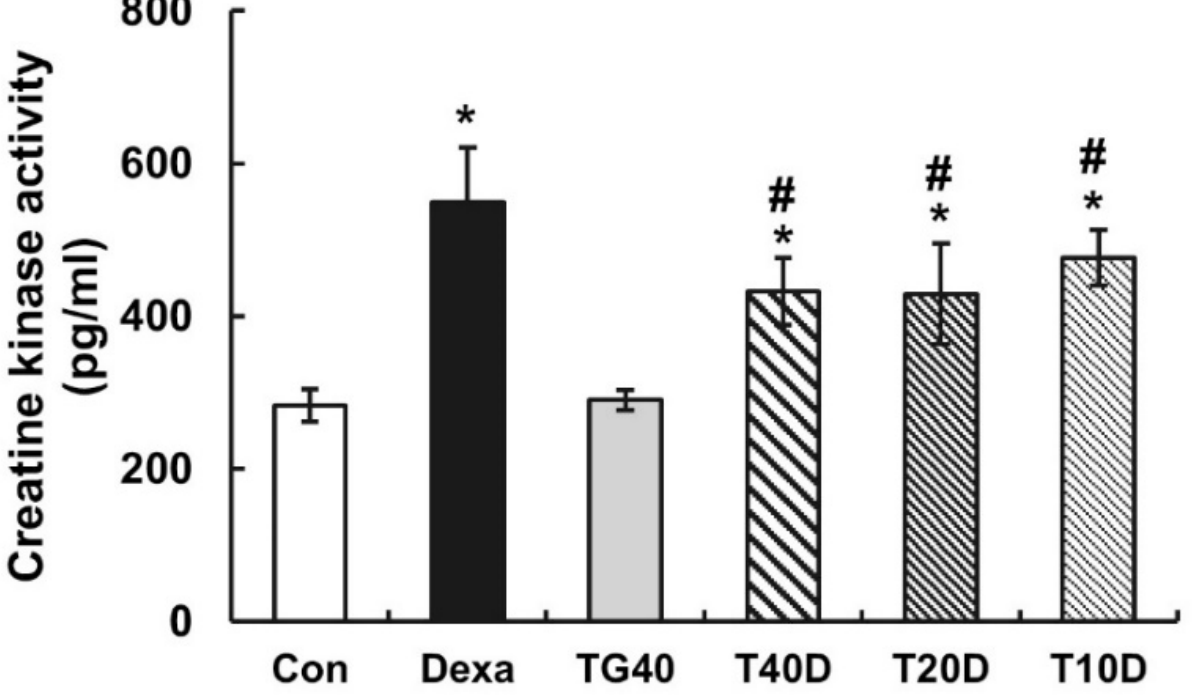
Figure 4. Effects of teaghrelin on the levels of serum creatine kinase in Dexa-treated rats. At the end of experiment, the levels of serum creatine kinase in the blood of the rats were measured by using ELISA. The Con, Dexa, TG40, T10D, T20D and T40D groups are defined in Figure 1. The results were analyzed using one-way ANOVA. Values are presented as the mean ± SD (n = 5 or 6). * p < 0.05 versus Con; # p < 0.05 versus Dexa.